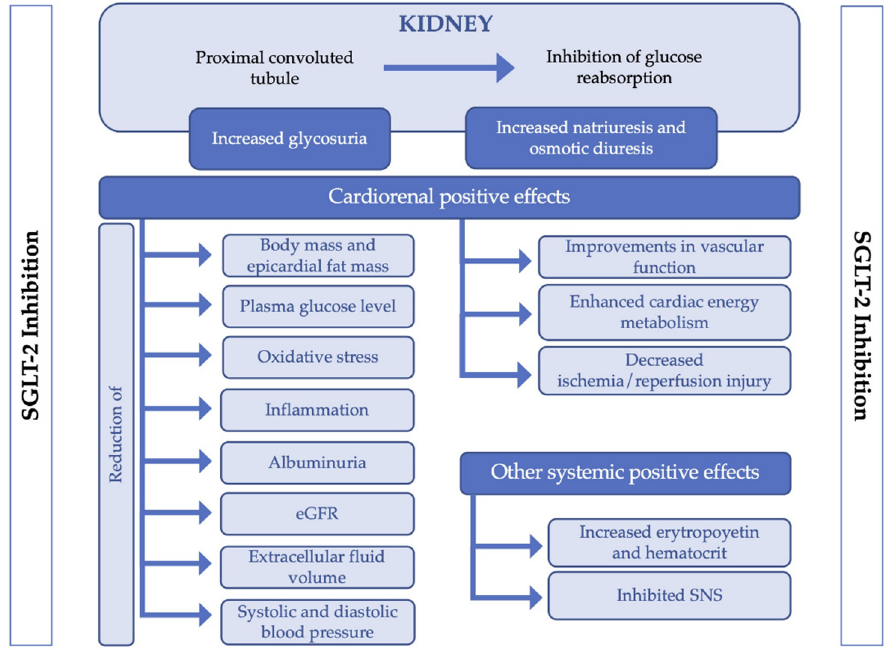
Figure 1. Mechanism of action of SGLT-2 inhibition and related positive effects. Abbreviations: eGFR: estimated Glomerular Filtration Rate; SNS: Sympathetic nervous system.